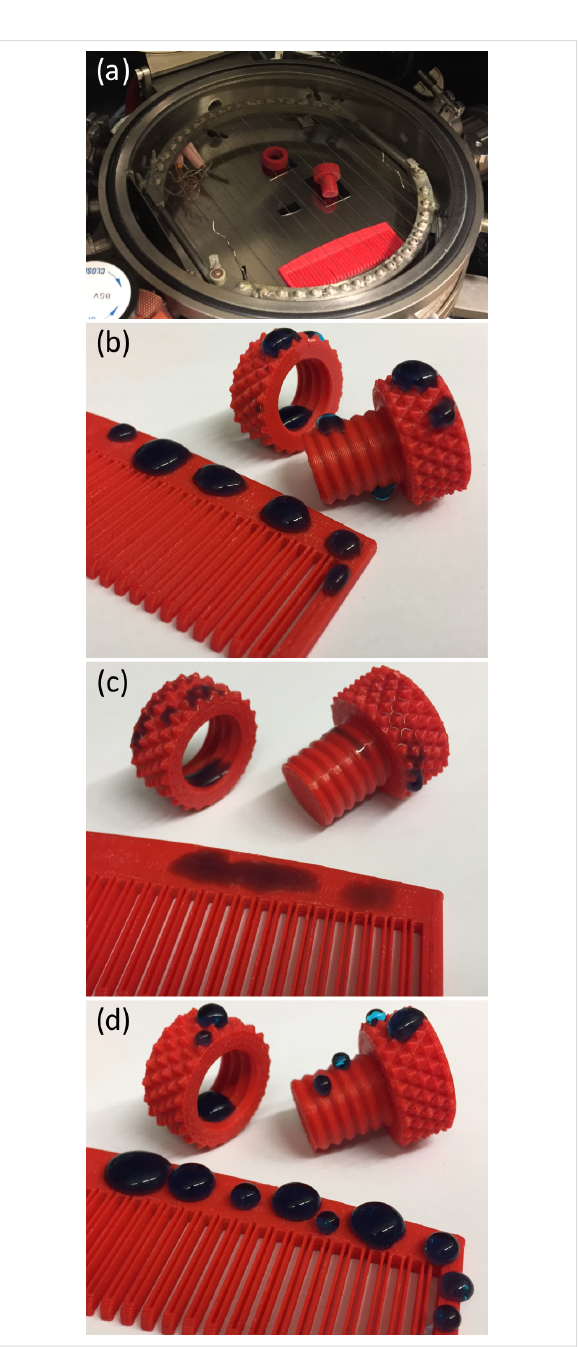
Figure 6: Sequential deposition of P(HEMA- co -EGDA) and PPFDA. (a) Nut, bolt, and comb in the iCVD reactor. Water droplets (colored with blue food coloring) on ABS substrates (b) without coating, (c) coated with P(HEMA- co -EGDA), and (d) coated with PPFDA.